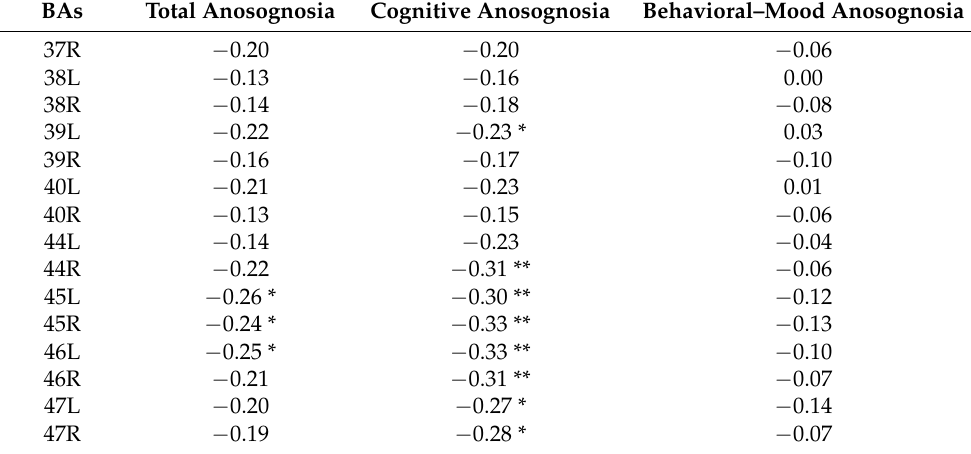
Figure 2. Brain perfusion SPECT with 99mTc-HMPAO in a 55-year-old woman with behavioral variant of frontotemporal dementia, Addenbrook’s Cognitive Examination—Revised score 67, 6 years of education, and total anosognosia score 29, showing hypoperfusion in inferior temporal cortex, anterior cingulate cortex, and inferior frontal gyrus, mainly of the right hemisphere.